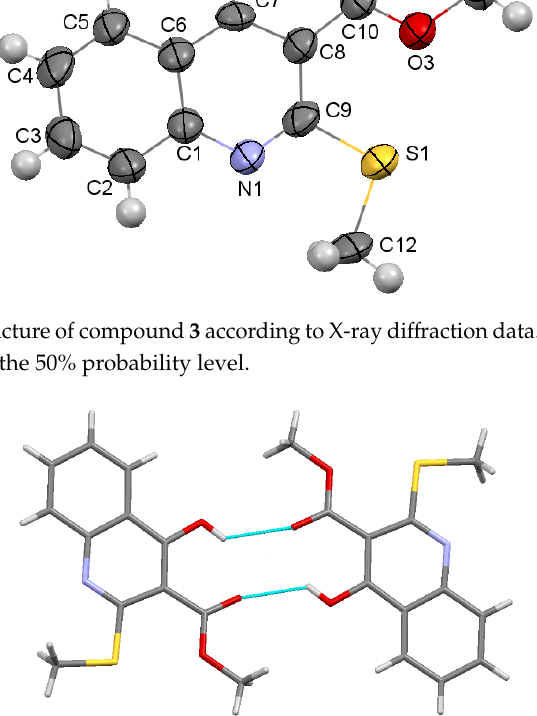
Figure 6. Centrosymmetric dimer of molecules 3 in the crystal phase. Hydrogen bonds are shown by dashed blue lines.